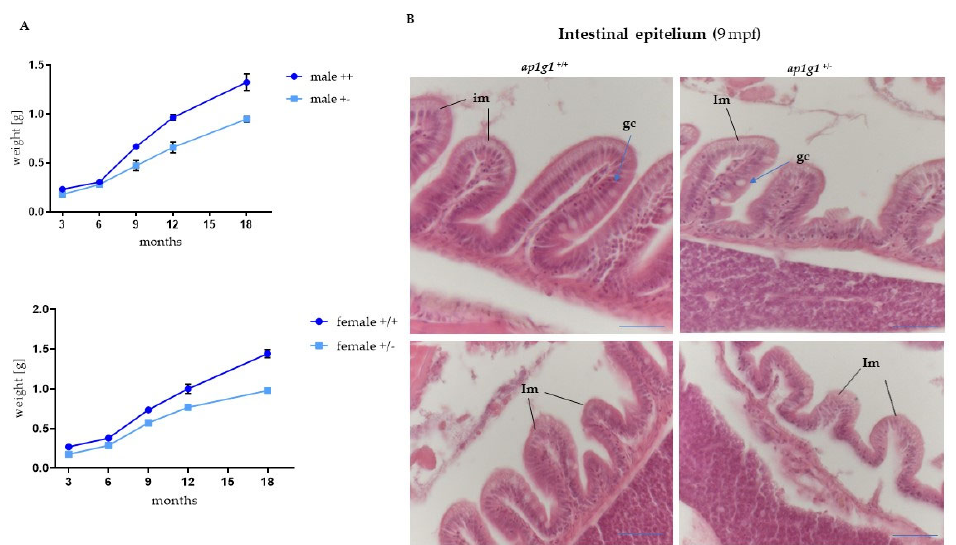
Figure 4. Histological analysis of intestinal epithelium in adult fish. ( A ) Growth curve of ap1g1 +/+ and ap1g1 +/ − . Body weight (in gr) was measured at different ages of adult life from 3 to 18 months. Both males’ and females’ ap1g1 +/ − body weight is significantly lower compared to ap1g1 +/+ . Statistical significance was determined by multiple t-test comparing each age group. For each group, 10 individuals were used and data was derived from two different experimental groups. ( B ) Histological analysis of ap1g1 +/+ and ap1g1 +/ − intestinal mucosa with abnormal epithelium at the villous tips and reduced height of villi in the heterozygous mutant at 9 months age-old compared to wild-type homozygous fish. Scale bar = 100 µ m Abbreviations: im: intestinal mucosa; gc: globet